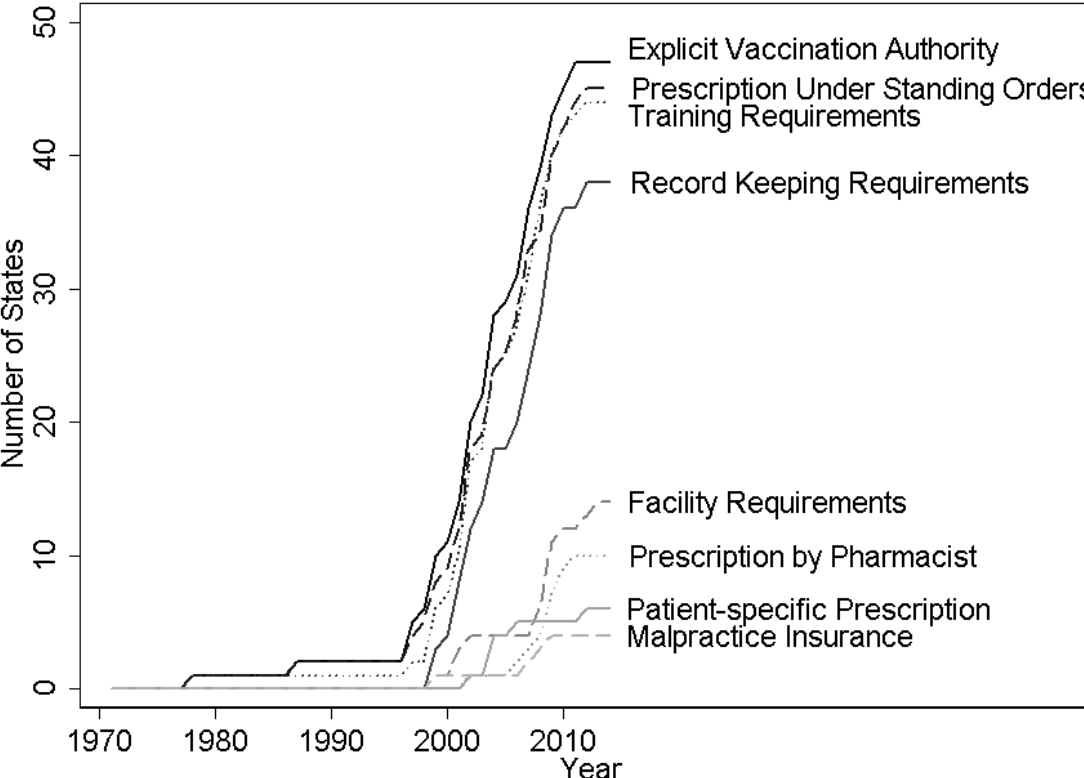
Figure 1. Expansions and limitations on pharmacists’ vaccination authority, 1971–2014. Note: Figure shows count of states in each year that give pharmacists the indicated vaccination authority or impose the indicated requirements for pharmacists to administer vaccines. Data from WestLaw Classic and WestLawNext legal